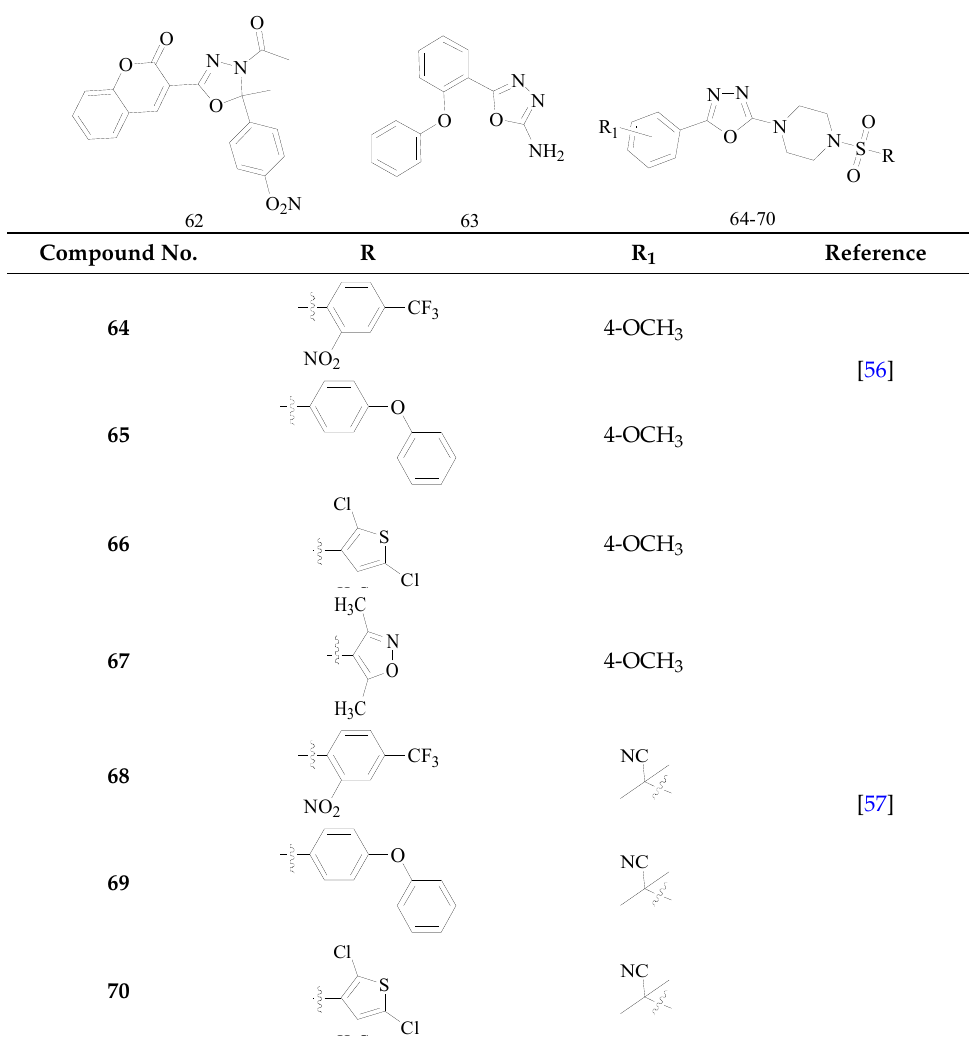
Table 4. Anticonvulsant oxadiazole or benzoxazinone compounds.